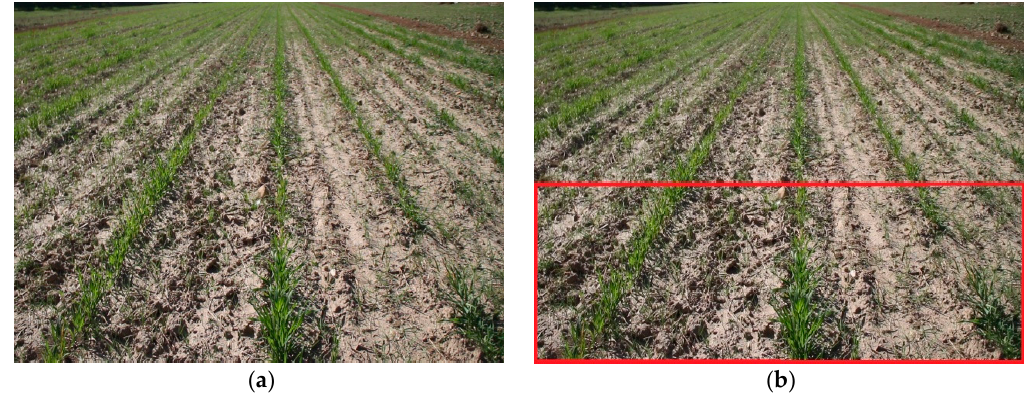
Figure 4. ( a ) A typical image acquired by the camera of the robot. ( b ) The working area of the image is delimited in red.